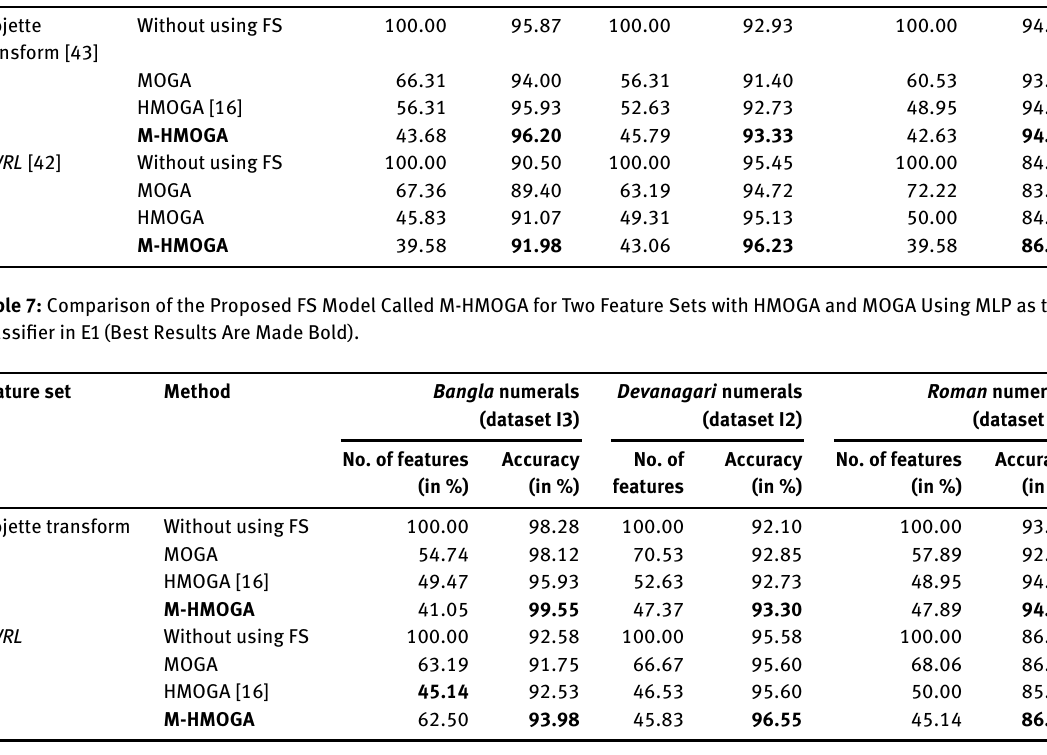
Table 8: Time Required by M-HMOGA Using (A) KNN Classifier and (b) MLP Classifier Over Different Datasets for Optimal Parameter Settings in